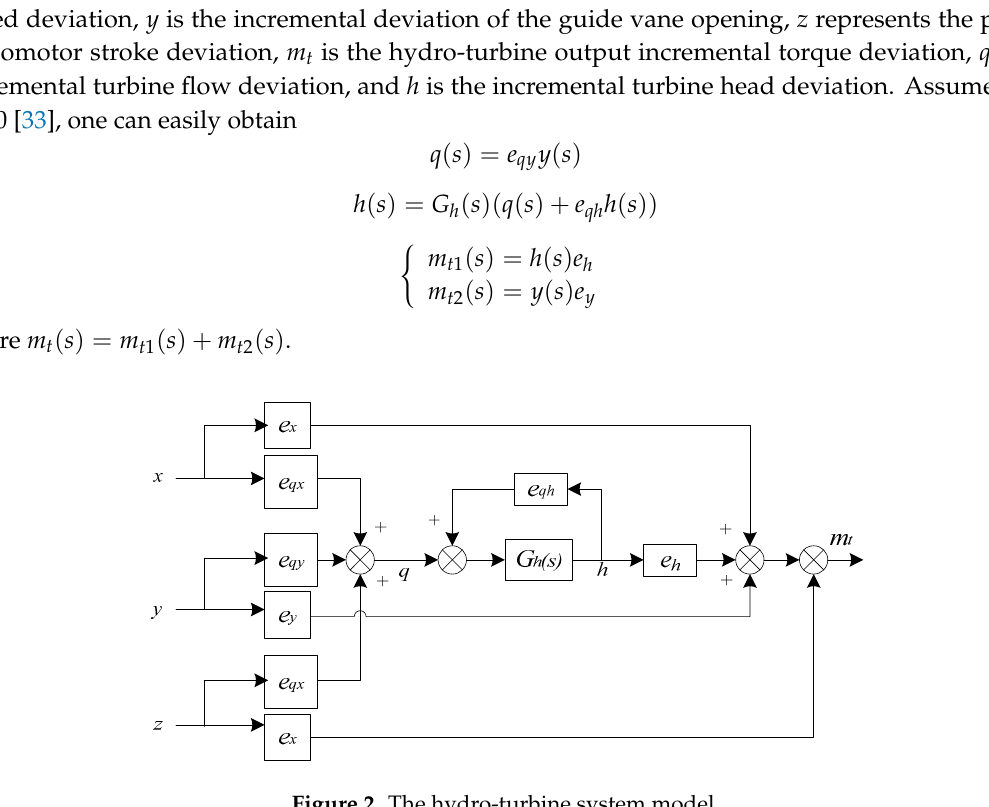
Figure 2. The hydro-turbine system model.